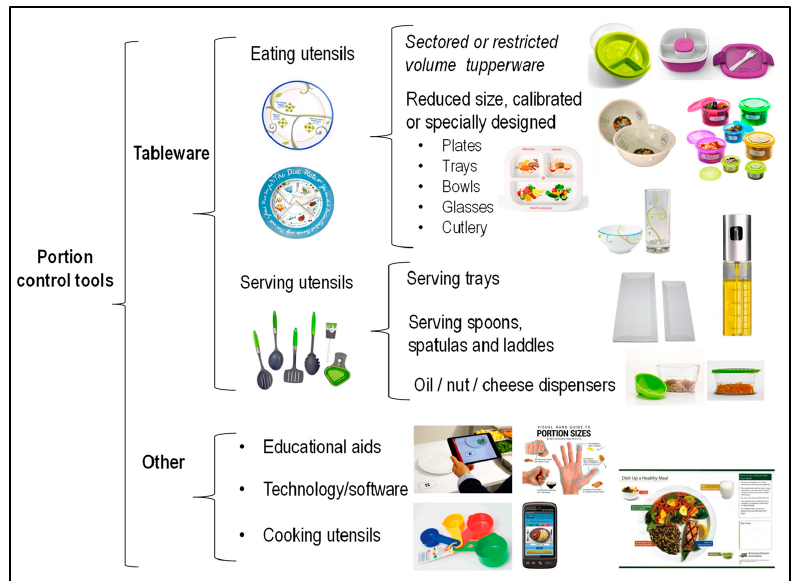
Figure 2. Taxonomy of available portion control tools (compiled by the authors from various sources; see text and Supplementary Table S1). Pictures of calibrated tableware, portion control pots and An overall description of each paper including details of the main outcomes is pre- sented in Table 3 (portion size awareness), Table 4 (portion size choice), Table 5 (portion size intake) and Table 6 (weight status). Further details of all publications can be found in the Supplementary Table S1.